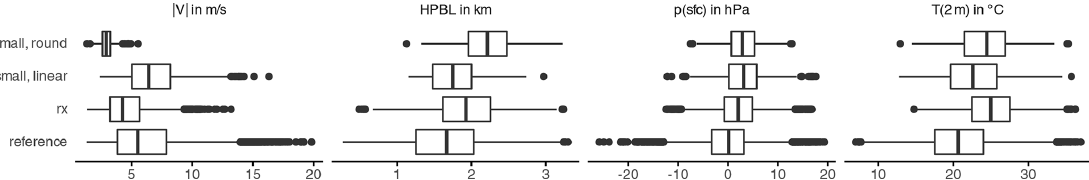
Figure 6. COSMO-REA2 level-45 wind speed, boundary layer height, surface pressure anomaly, and 2m temperature during summer (JJA) between 11:00 and 13:00UTC, averaged around the selected radar locations. “Small and round” cases have z < 1 . 68 ,ρ < 0 . 08, and “small and linear” cases have z < 1 . 68 ,ρ > 0 . 46. The values for all remaining cases are included in the “reference” box plots. The box plot labeled “rx” contains all instances in which at least one clear-air radar echo is